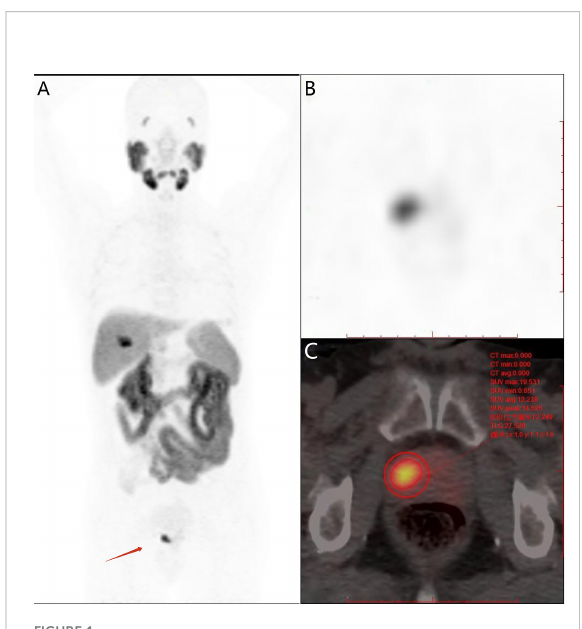
FIGURE 1 Semi-quantitative parameters of the primary prostate tumor were measured on 18 F-PSMA-1007 PET/CT imaging by the 3D sketching method. (A) Primary prostate cancer was revealed on whole-body maximum intensity projection (MIP) imaging (red arrow); (B) the prostate positive lesion was shown on axial PET imaging; (C) the volume of interest of the prostate lesion was obtained on axial fusion image (smaller red circle surrounding the lesion). SUVmax and PSMA-derived tumor volume (PSMA- TV) of the lesion were obtained by the threshold method as 19.25 and 2.39 cm 3 , respectively, and the workstation automatically calculated total lesion PSMA (TL-PSMA) of the lesion as 27.83 cm 3